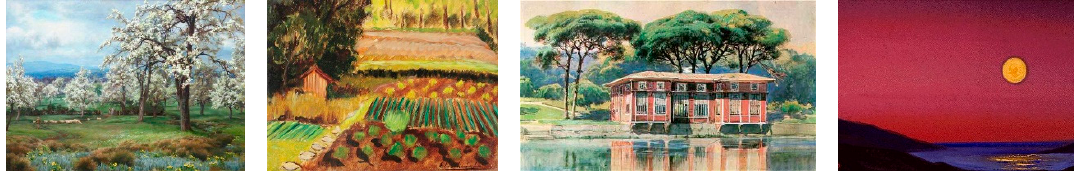
Figure 1. Examples of paintings from the WikiArt dataset.